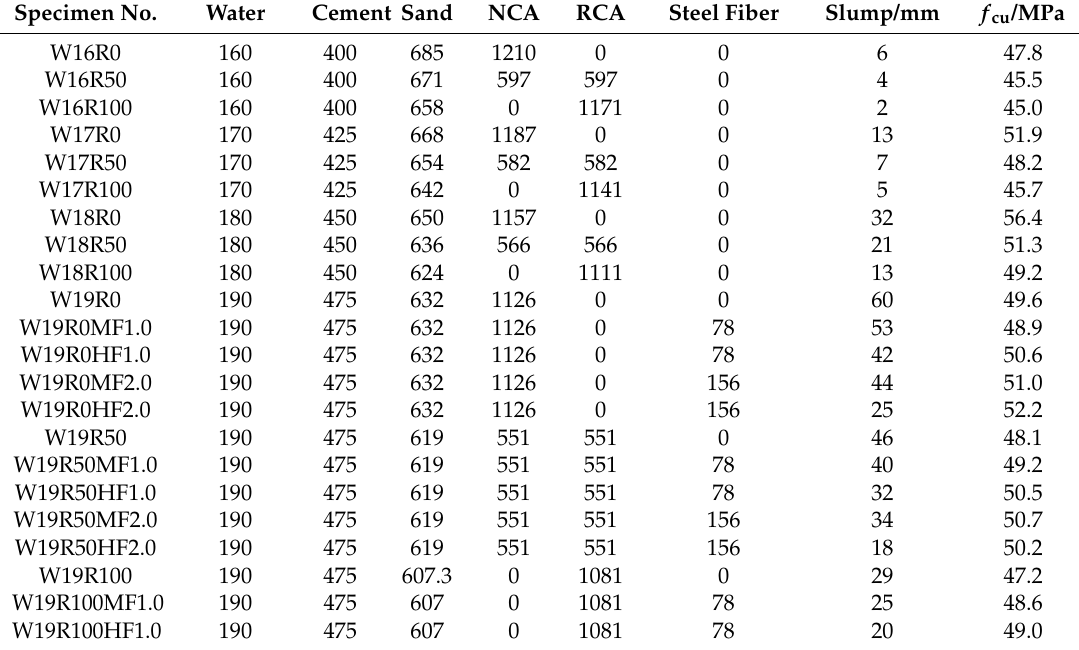
Table 6. Mixture design (kg/m 3 ) and compressive strength of steel fiber reinforced recycled coarse aggregate concrete (SFRCAC) with different water content. Specimen